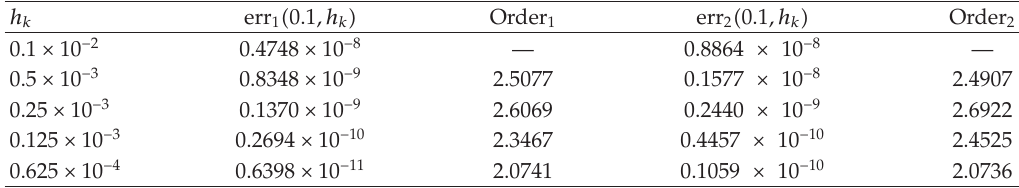
Table 2: The error and the convergence